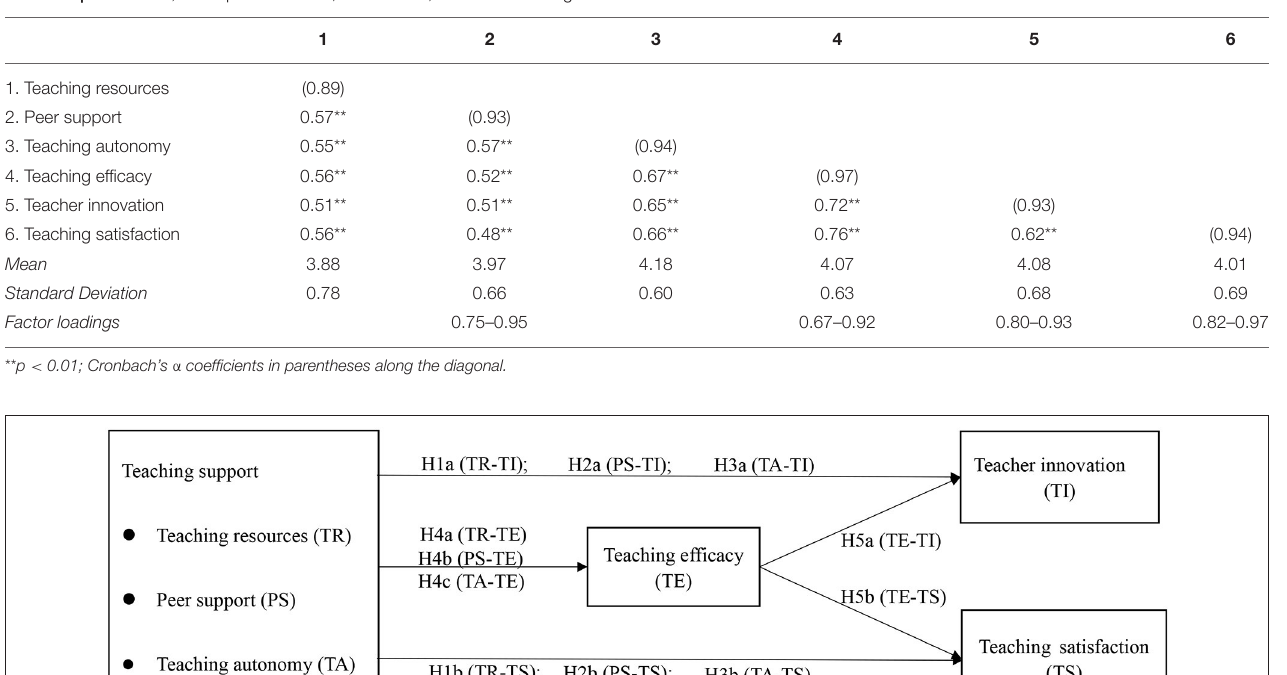
TABLE 2 | Reliabilities, descriptive statistics, correlations, and factor loadings.